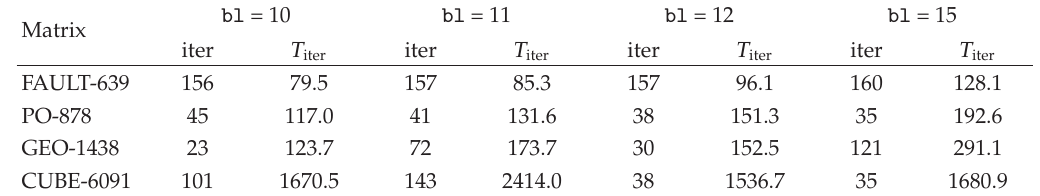
Table 5: Iterations and CPU time for the iterative solver of LOBPCG- hypre preconditioned by Parasails with di ff erent values of bl and p (cid:4) 16